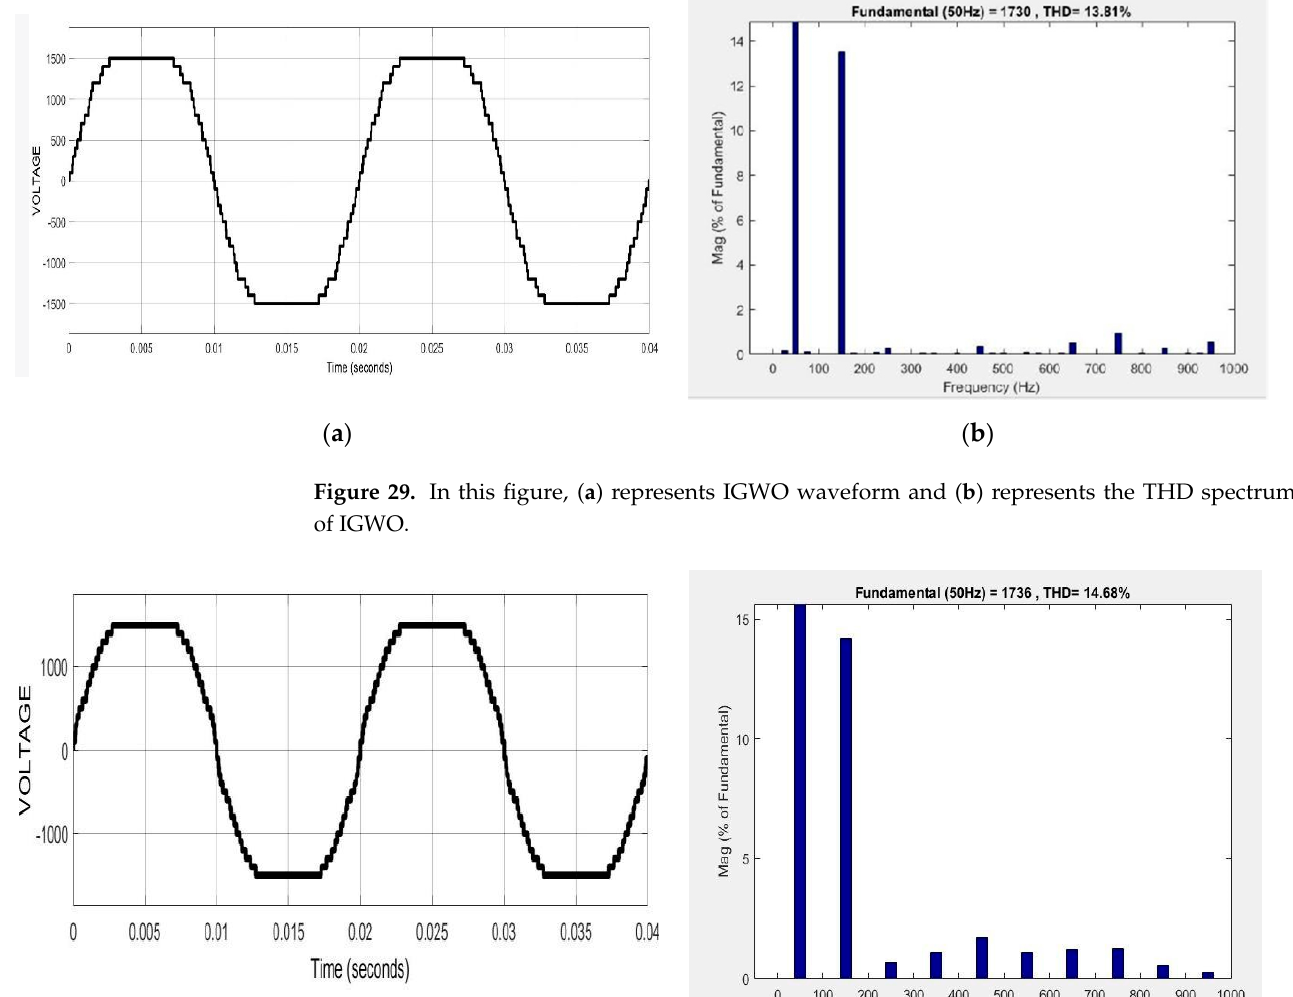
Figure 30. In this fi gure, ( a ) represents GWO waveform and ( b ) represents the THD spectrum of GWO.